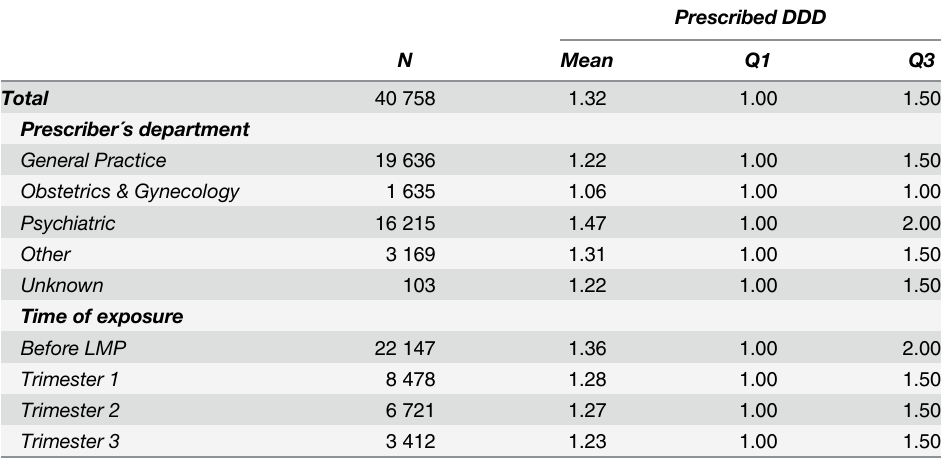
Table 3. Number of filled prescriptions (N) and prescribed defined daily doses (DDD) during preg- nancy according to text analysis of Swedish prescriptions of